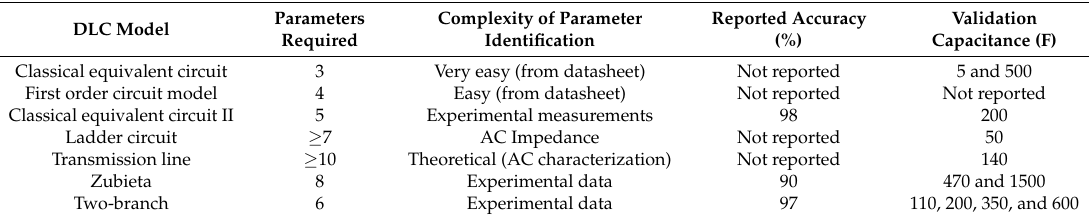
Table 1. Comparisons of the different electrical DLC models